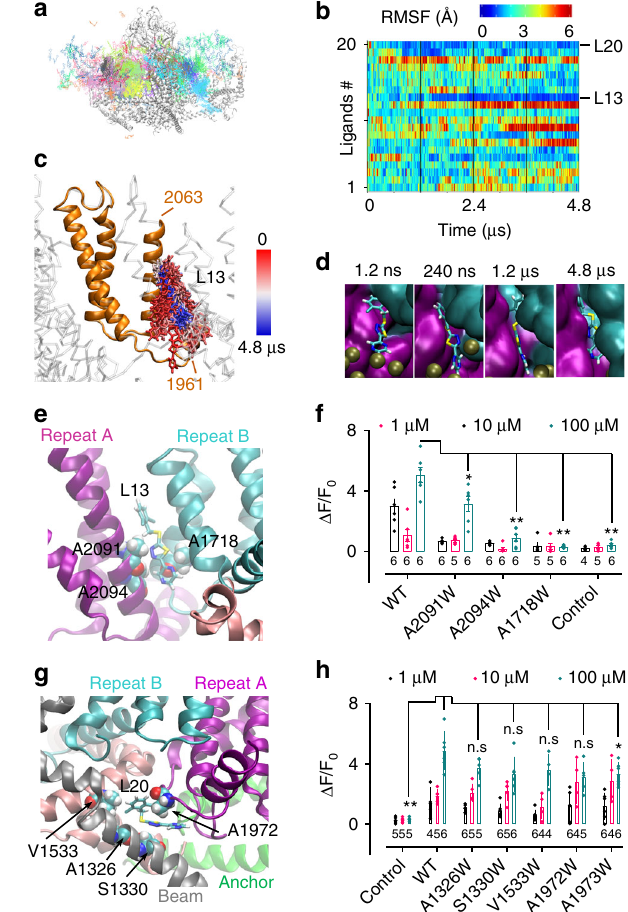
Fig. 1 Membrane curvature and cation-selective pore fenestrations. a RMSD for protein backbone atoms during MD simulation. b Snapshots showing evolution of water density (shown as gray) around Piezo1 (shown as colored protein backbone). c Curvature radius plotted over time for the upper (red) and lower (cyan) lea fl ets. Dots represent individual time point curvature calculations, and lines represent LOESS fi t with span of 4.7% of the total time using ggplot2 geom_stat function. d Detailed view of the channel pore showing the three inner helices and water molecules within 5 Å of protein backbone at t = 4.8 µ s. Side chains are shown in one inner helix for clarity. e Pore region showing accumulated K + (blue spheres) and Cl - (red spheres) ions within 5 Å of backbone and sampled every 24 ns during the fi rst 4.8 µ s (backbone shown at t = 4.8 µ s). IH, inner